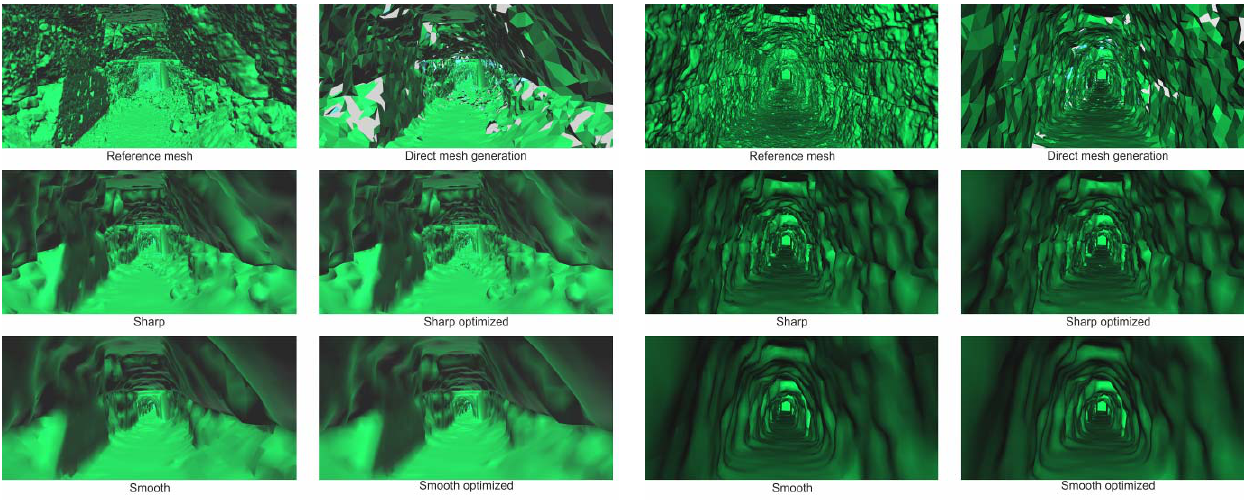
Figure 6. Example of the simplification approach in a high-detail area of the underground passage (10 cm mesh).